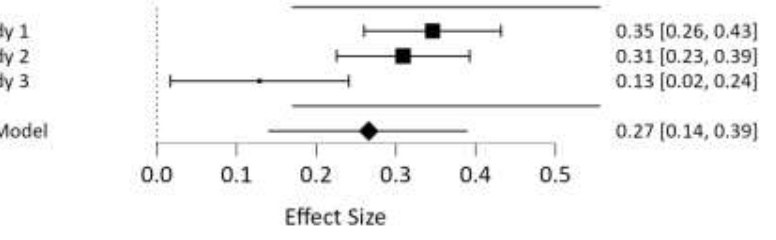
Figure 27 . Forest plot of meta-analysis of Motivation for stimulation and L2 test